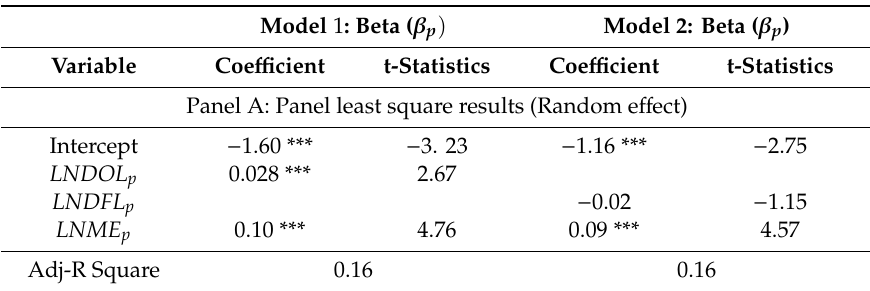
Table 6. Portfolio Systematic Risk regression